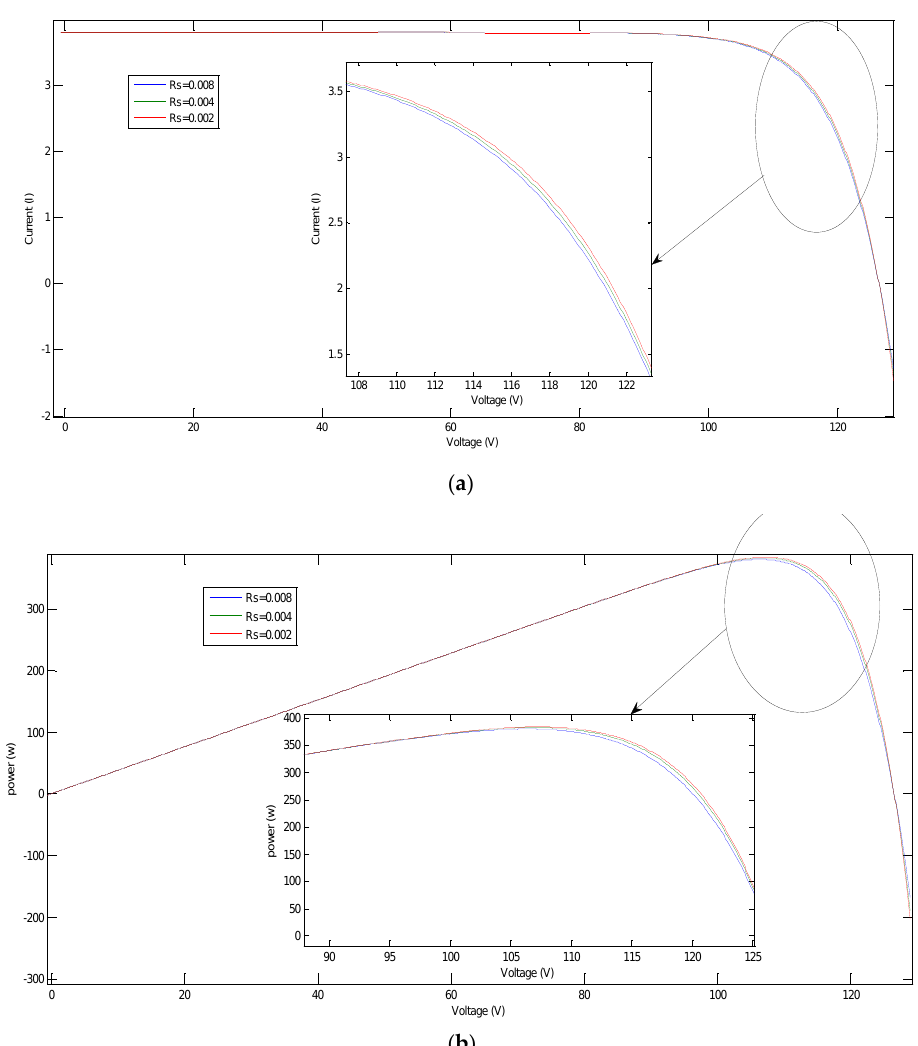
Sensors 2021 , 21 , x FOR PEER REVIEW